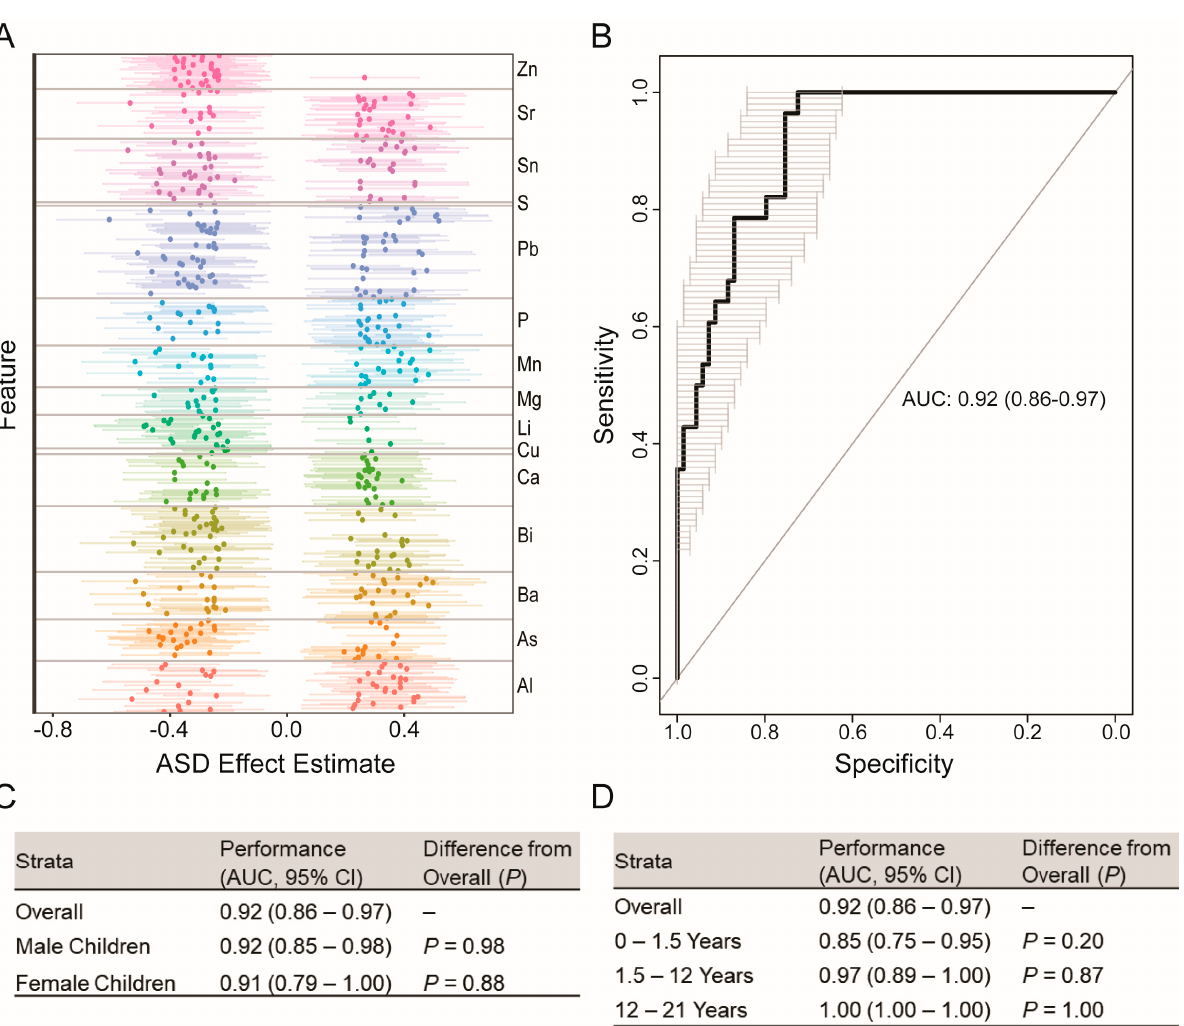
Figure 2. Elemental pathways associated with ASD diagnosis: ( A ) For each of 210 features measured in each elemental pathway, we constructed a discrete generalized linear model to test for associations with odds of diagnosis with ASD. Models were adjusted for age and sex, and p -values associated with diagnostic status were adjusted via false discovery rates (FDRs). x-axis plots the standardized effect estimate for the effect of ASD diagnosis; dots and corresponding lines reflect the effect estimate and associated 95% confidence interval for each feature. ( B ) Receiver operating characteristic [38] curve generated from predicting case status in the validation set ( n = 97; 28 ASD). ( C ) Comparison of overall model performance with sex-stratified estimates of model performance. p -values reflect comparison of sex-stratified ROC curves relative to ROC curves in the overall model. ( D ) Comparison of overall model performance with age-stratified estimates of model performance. p -values reflect comparison of age-stratified ROC curves relative to ROC curves derived in the overall